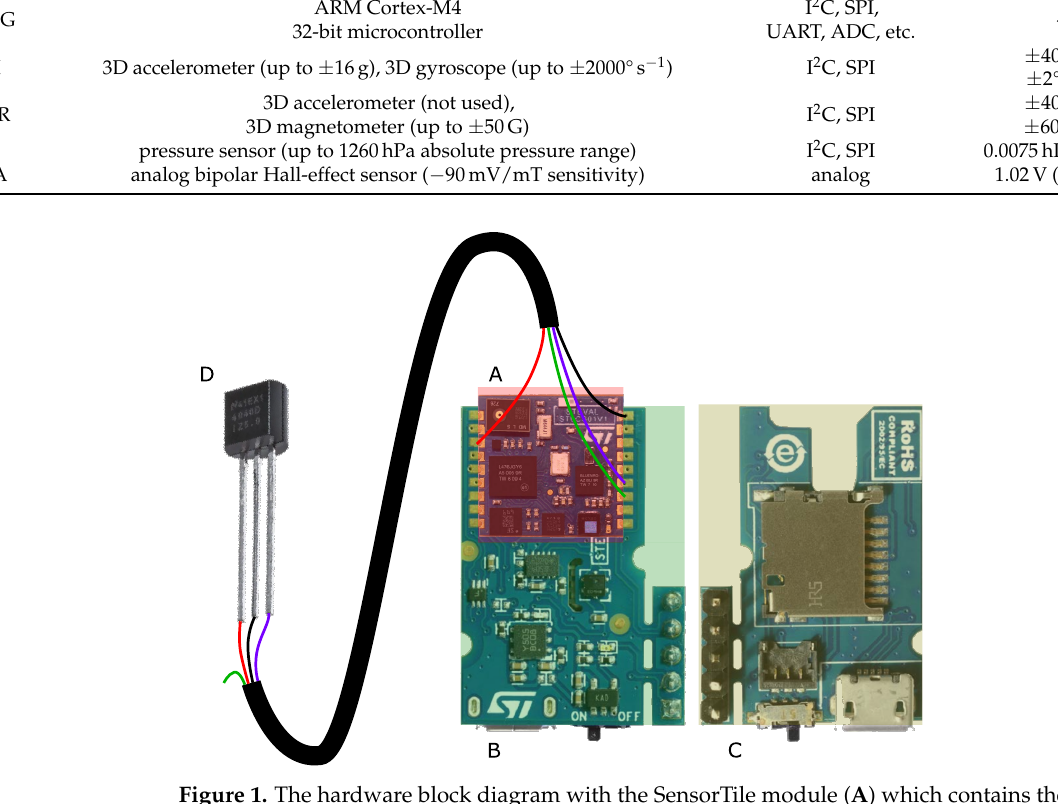
Figure 1. The hardware block diagram with the SensorTile module ( A ) which contains the IMU, the SensorTile Cradle board in top ( B ) and bottom view ( C ) [28] and the Hall-effect sensor ( D ) [29]. The connecting cable between Hall-effect sensor and SensorTile module has the supply voltage in red, the ground in black, the analogous Hall-effect sensor output in violet, and a spare wire in